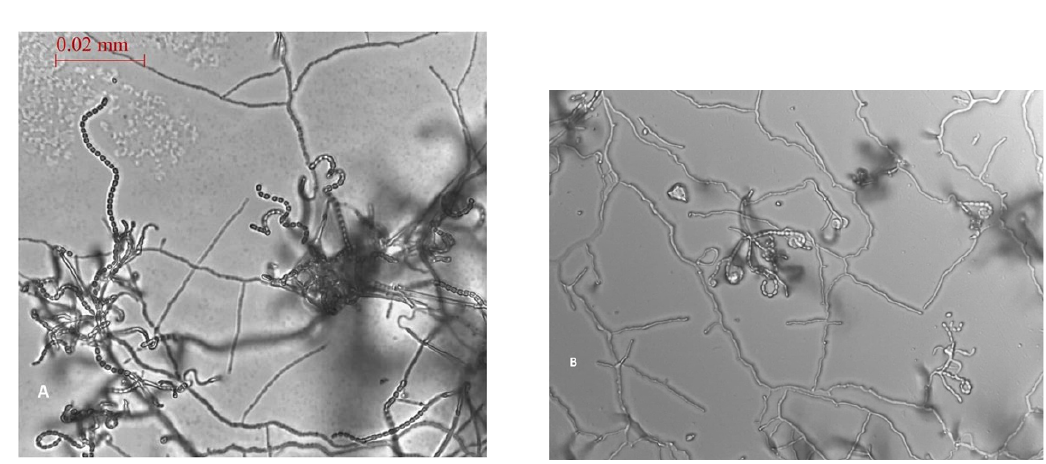
Fig. 1. Spore chain arrangement observed at 1000X. A) Isolate AC 45- Streptomyces lavenduligriseus , B) Isolate number AC 69 - Streptomyces